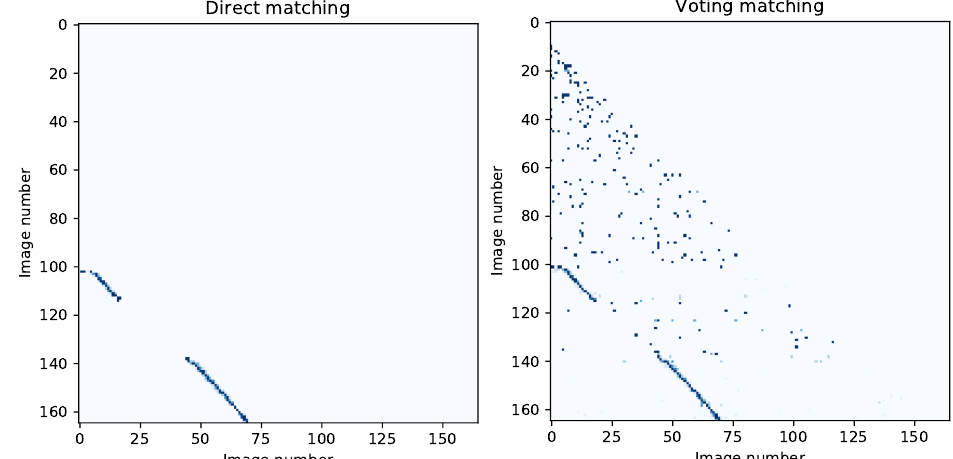
Figure 3. Comparison of a similarity matrix computed by matching directly the visual features and using the voting scheme propose in this work. Each entry ( i , j ) in this matrix indicates the similarity between image i and j . The darker an entry is, the more similar the associated images are. The main diagonals were eliminated from these matrices as they only indicate that the same image is similar to